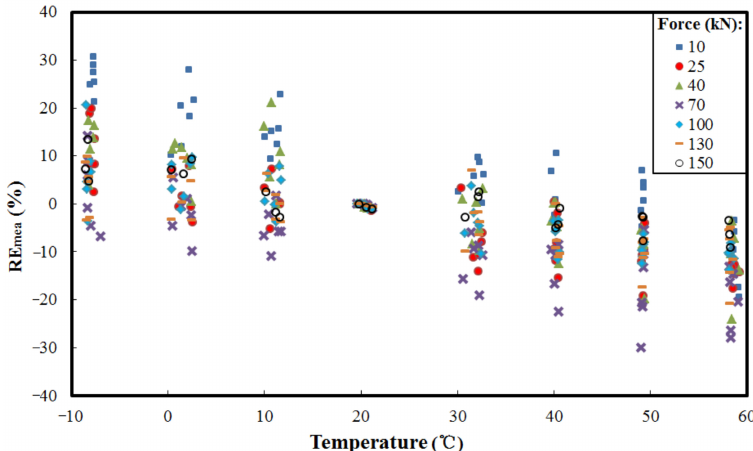
Figure 4. Relative error (RE mea ) of the output voltages from the EME sensor before compensation at different